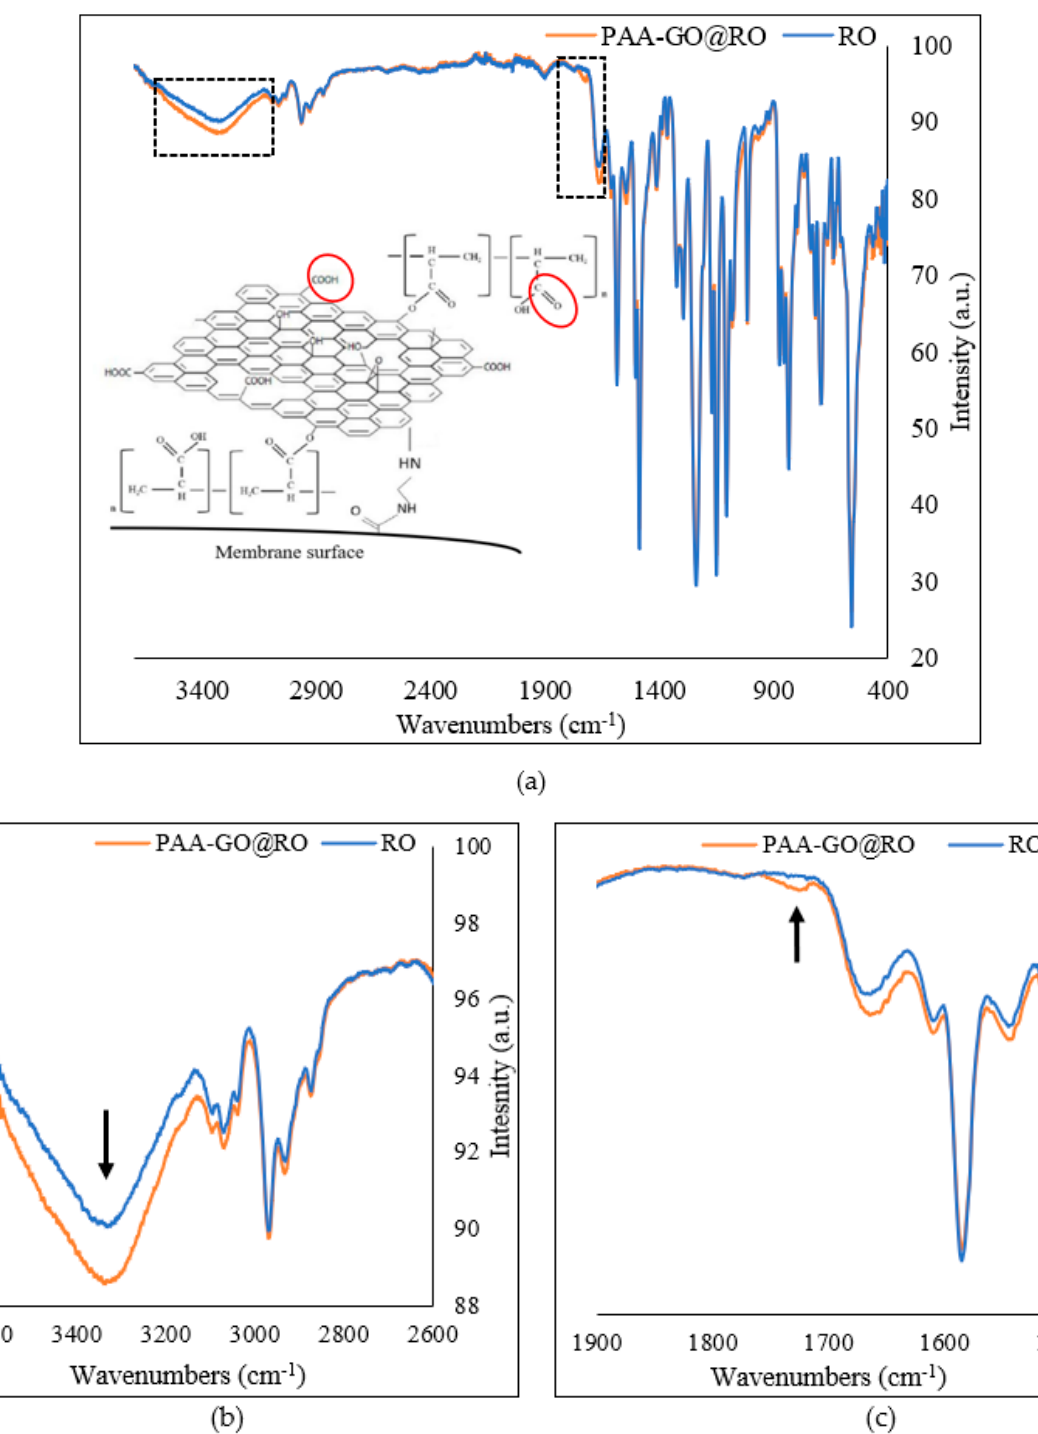
Figure 9. ATR-FTIR spectra of the membranes ( a ) complete spectra 3900–400 cm − 1 ; ( b ) spectral range 3900–2900 cm − 1 ; ( c ) spectral range 1900–1500 cm − 1. Figure 10 shows the Raman spectra of the RO and PAA-GO@RO optimized mem- brane. The difference in the peak intensity ratio of 1147 and 1585 cm − 1 can be used to demonstrate the difference between the two membranes. It was noted that the ratio de- creased from 1.08 for the RO membrane to 0.94 for the PAA-GO@RO membrane. This could be attributed to the presence of the G band from GO at 1590 cm − 1 [38]. The G band